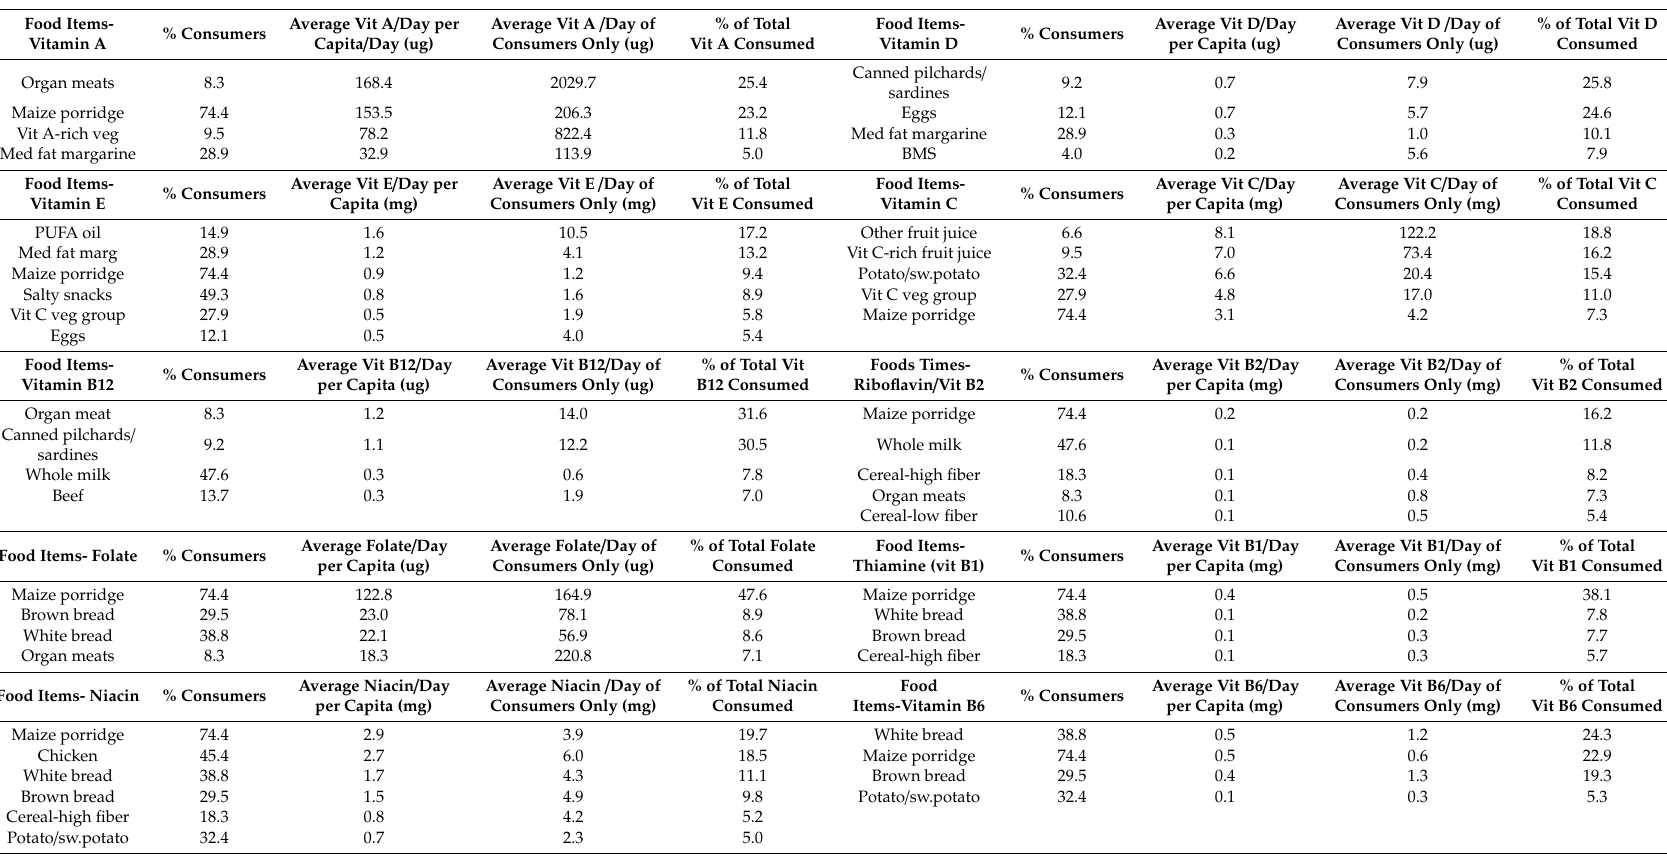
Table 6. Food items which have contributed at least 5% of total vitamin A, D, E and C intakes of children aged 1 to < 10 years (N =